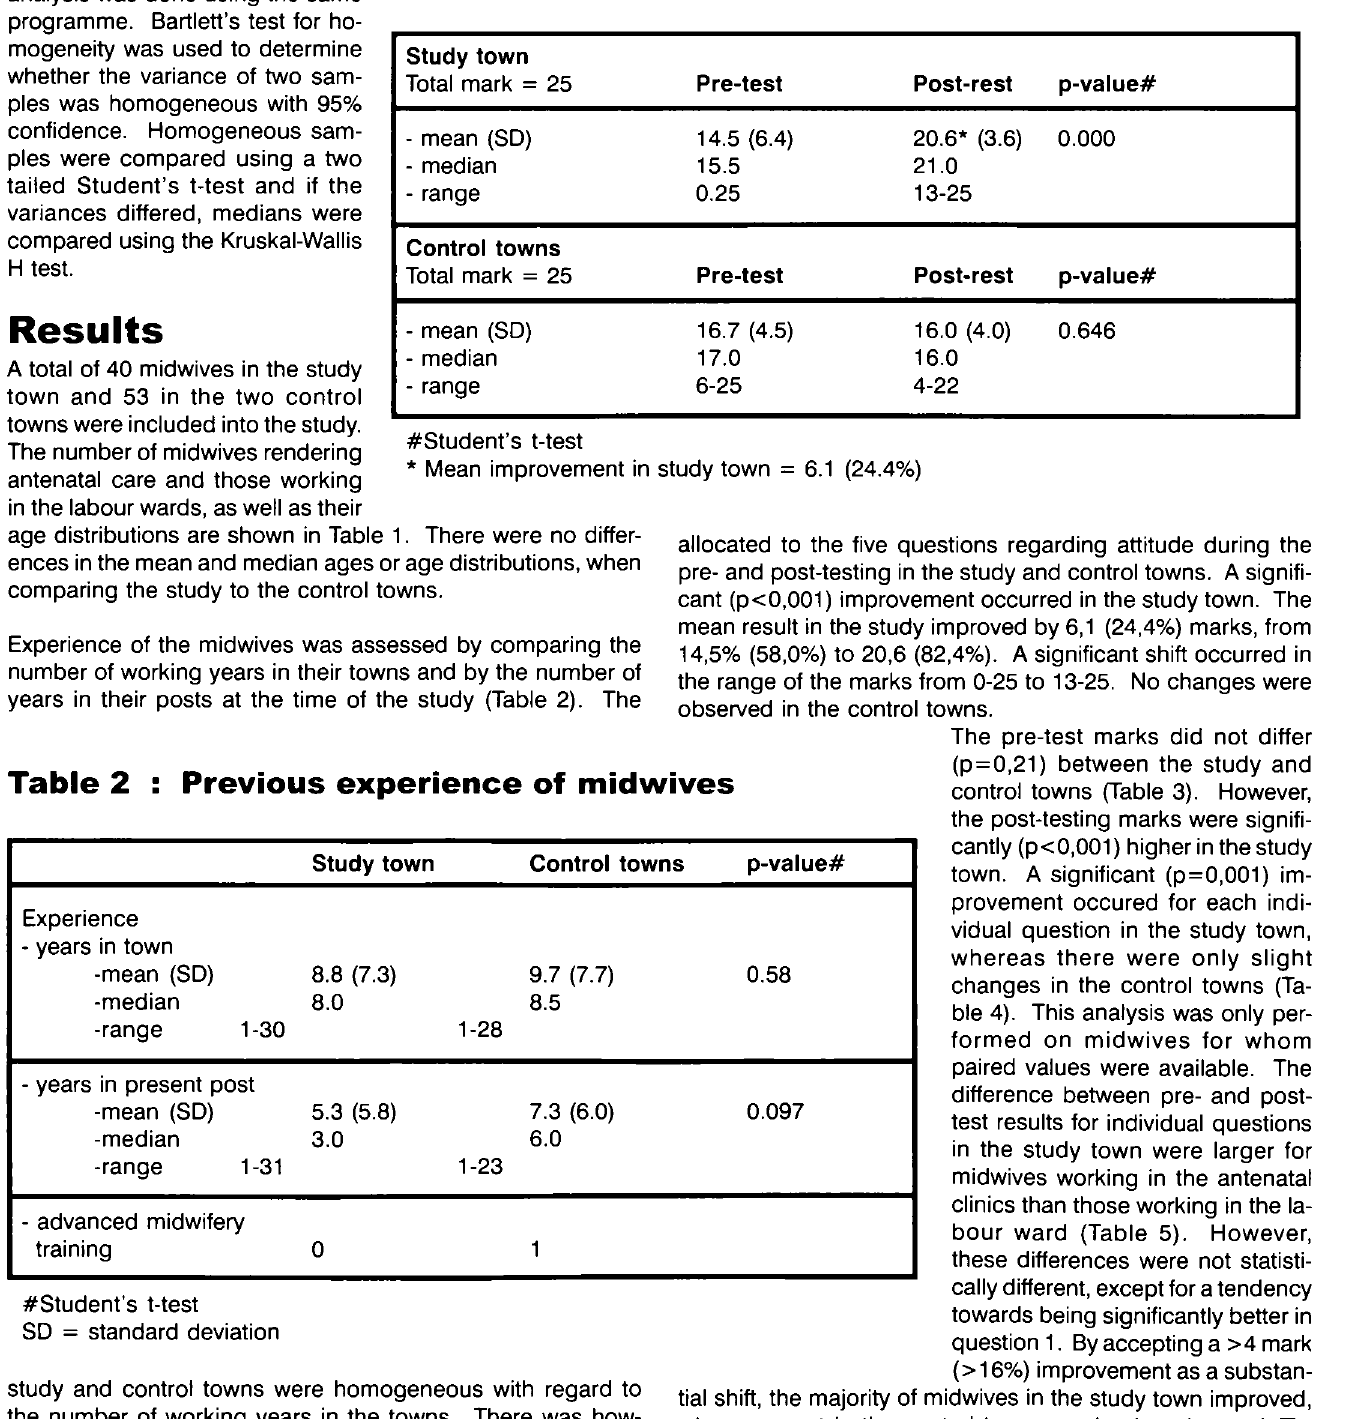
Table 3 : M arks obtained during pre- and